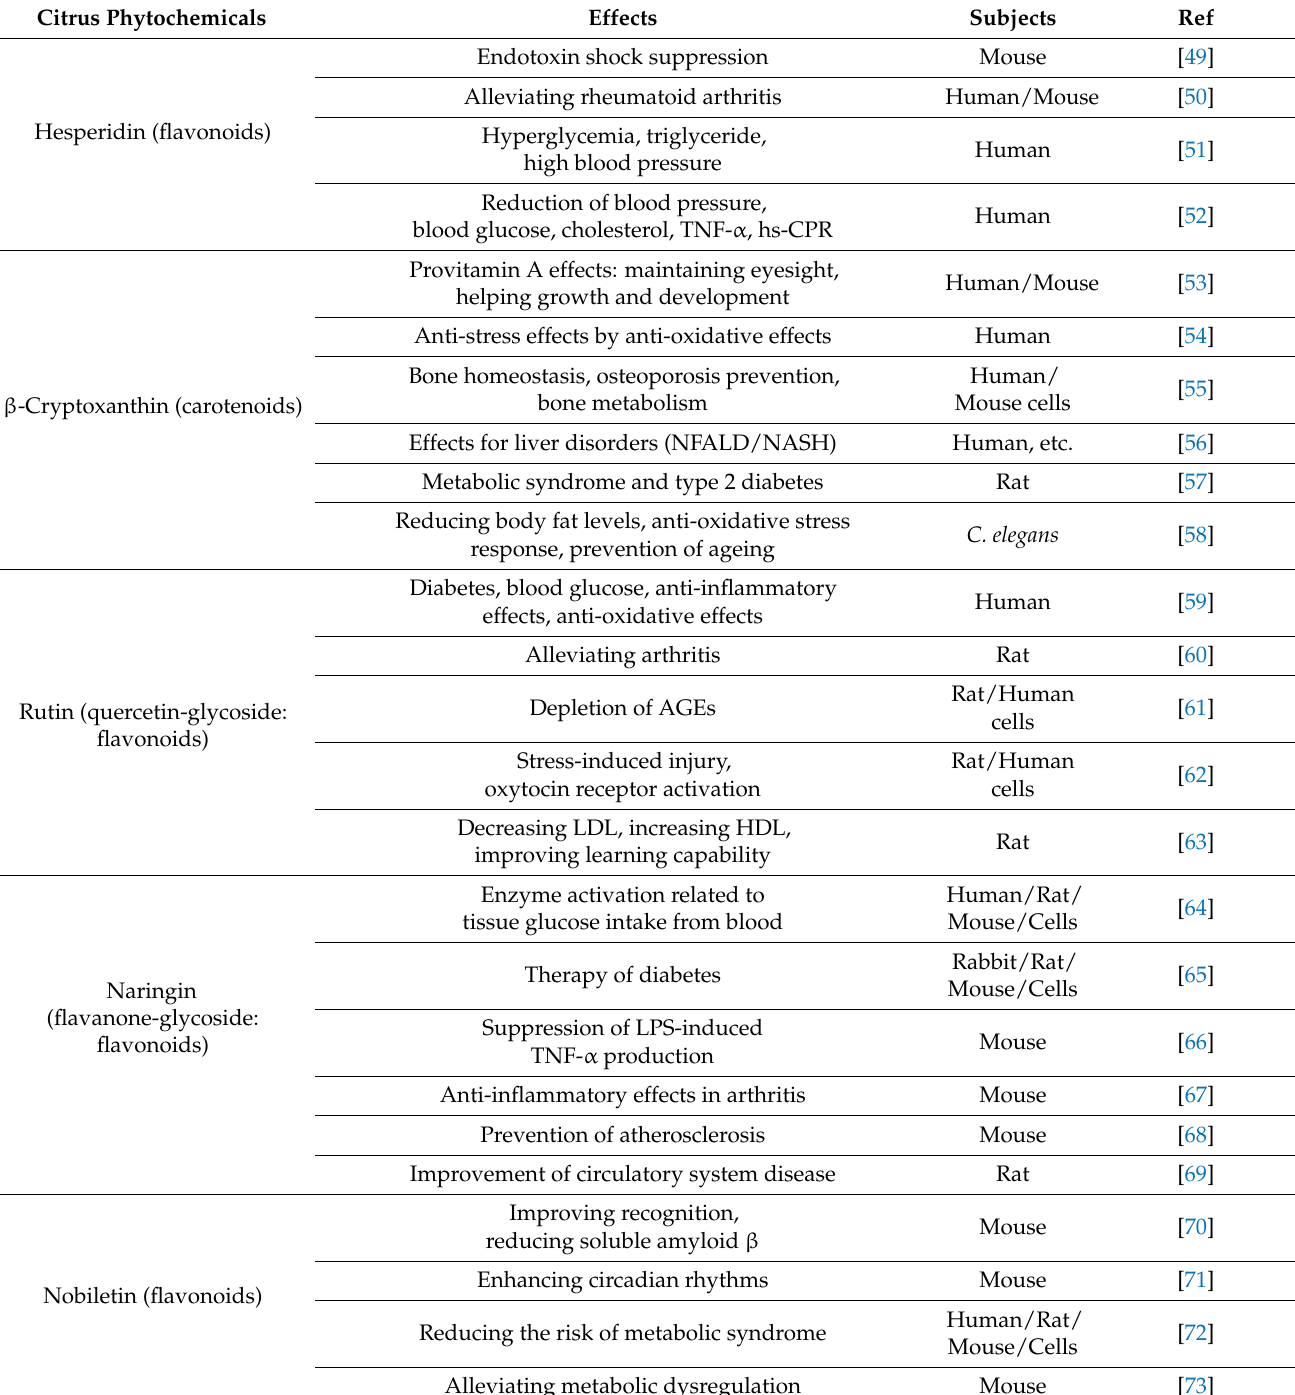
Table 1. Anti-metabolic syndrome and anti-inflammatory effects of citrus